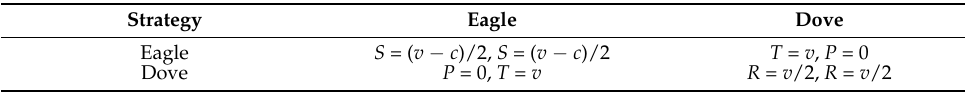
Table A1. A result payout matrix of Eagle Dove